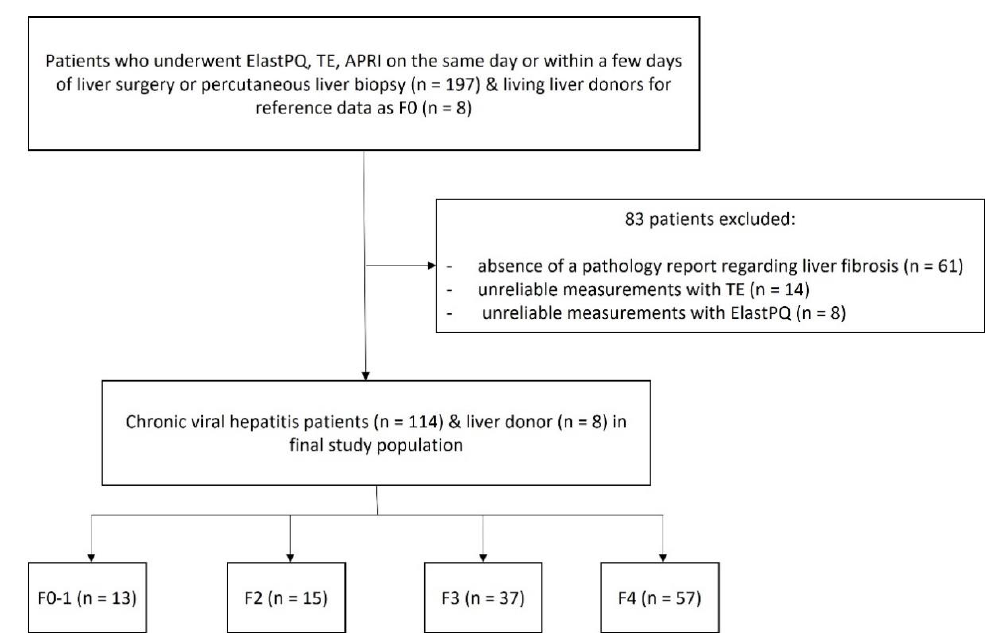
Figure 1. Flow chart of the study population.